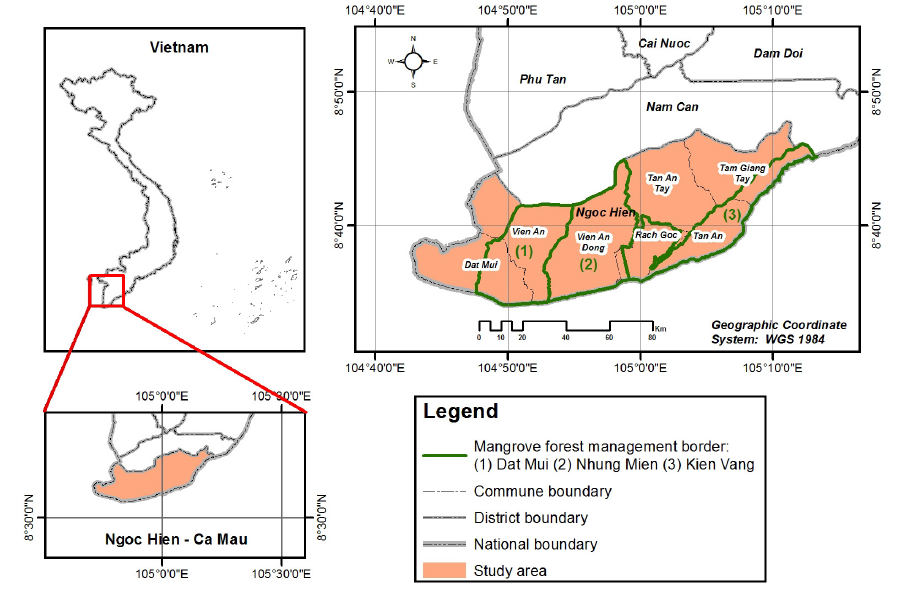
Figure 1. Location of study area. Table 1. Overview of used images, per sensor (Landsat-7 and Landsat-8) per scene pathway, and missing pixels and anomalous land use transitions assessed with temporal data fusion. Years impeded by the SLC-malfunction are shaded in grey. Missing Pixels LUC Anomalies Available Images for Gap Filling Detected Year LS-7 LS-8